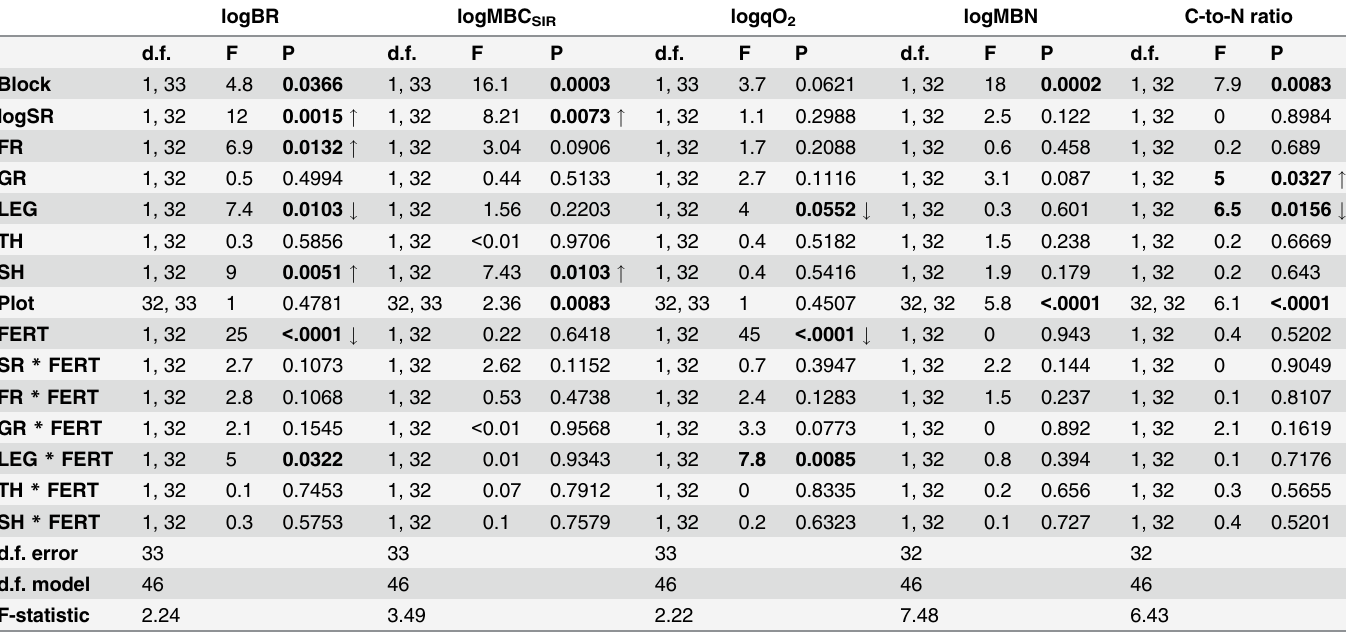
Table 1. Fertilization and plant community effects on soil microbial properties.